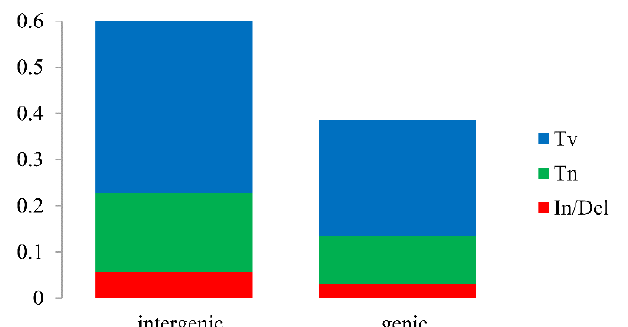
Figure 3. Transversion (Tv), transition (Tn) and Insert/Deletion (In/Del) were showed in intergenic and genic regions.